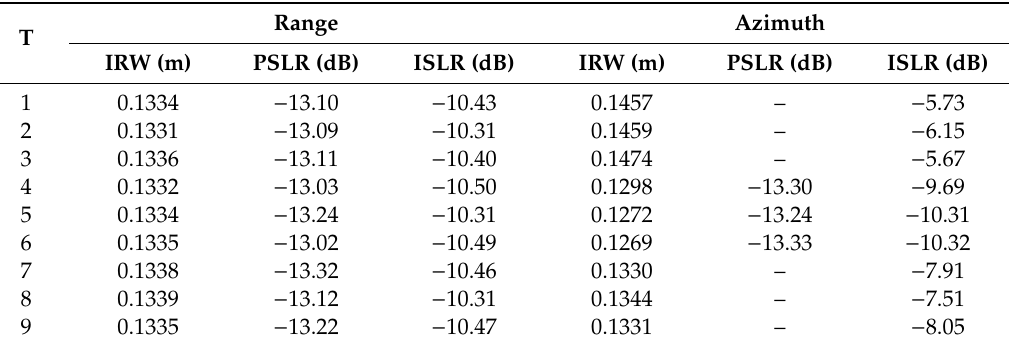
Table 3. Analysis of results with the generalized ω K.